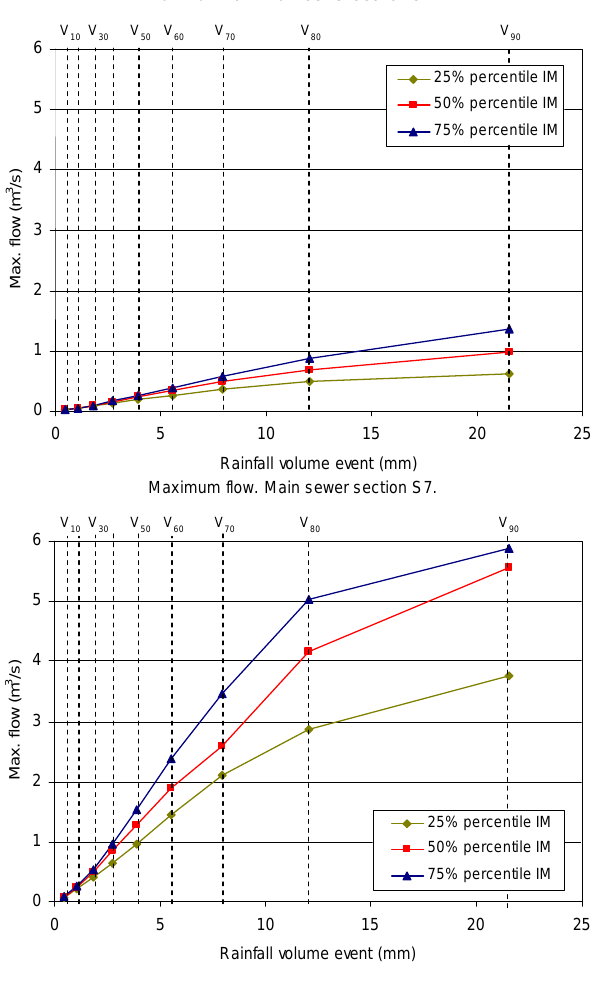
Fig. 4. Interception system diagnosis: maximum sewer flow.